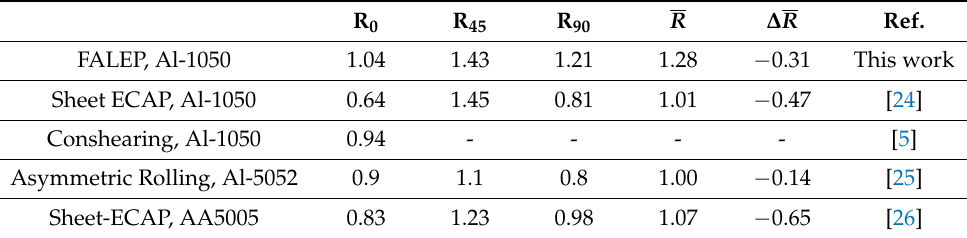
Table 2. Measured R -values in